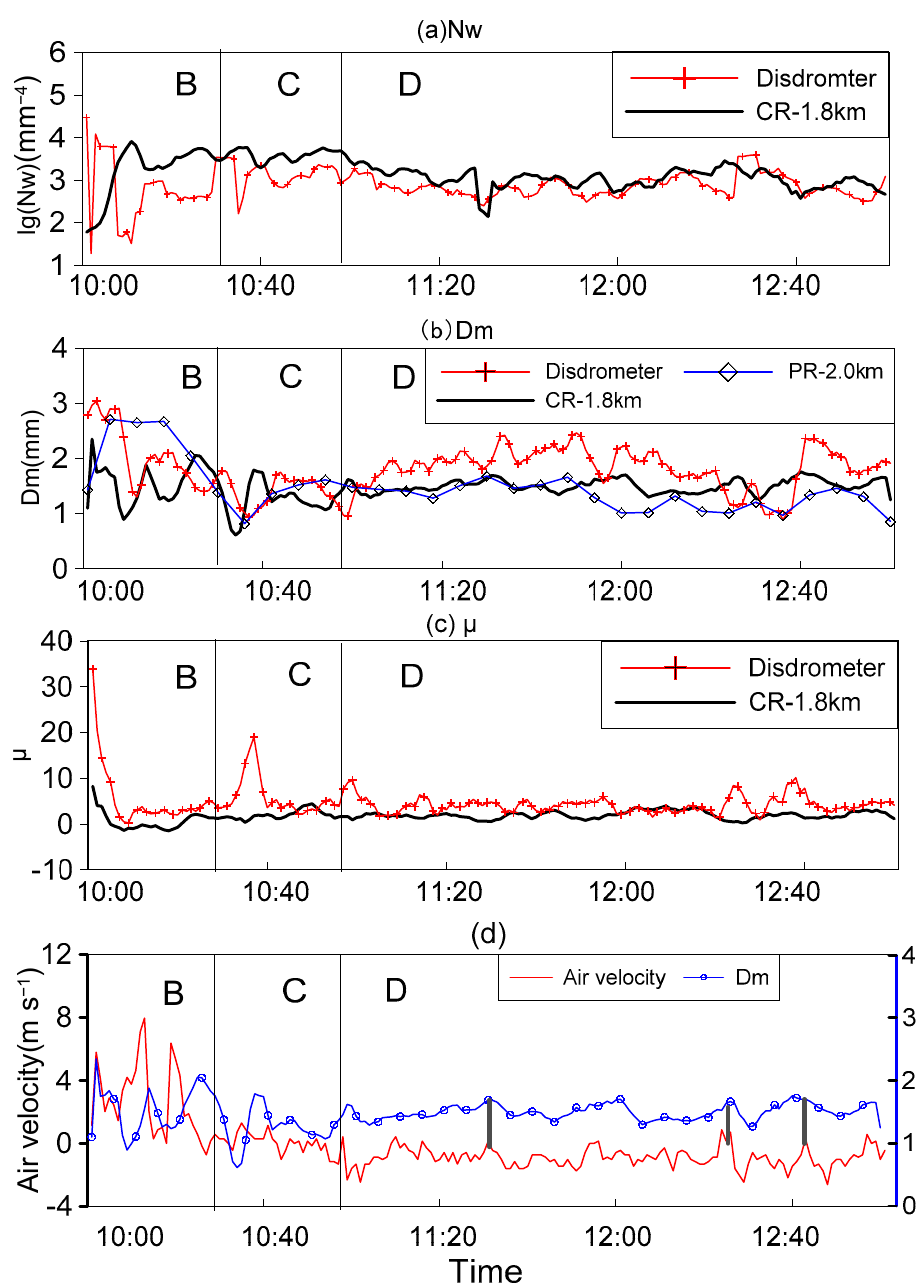
Figure 6. Time series of the three DSD fitting parameters at ground level retrieved by the disdrometer and at 1.8 km retrieved by CR during 0947–1300 UTC on May 6, 2016: ( a ) Nw (unit: mm − 1 m 3 ), ( b ) D m (unit: mm), and ( c ) μ . D m time series of PR at 2 km is represented by the blue line in ( b ). Time series of D m and vertical air velocity retrieved by CR are shown in ( d ), and the gray lines connect the peak values. Different stages of the squall line are divided by black solid lines, with the time segment before the passage of the squall line, the strong convection time segment, the transition time segment, and the stratiform cloud time segment labeled A, B, C, and D, respectively.